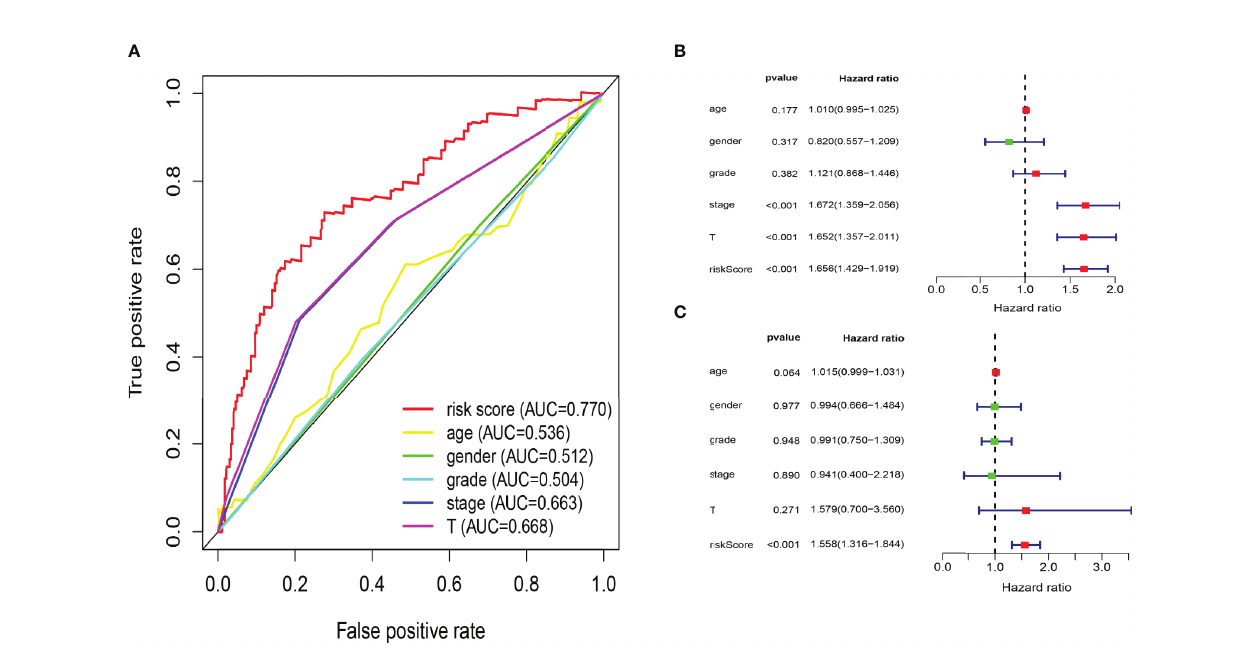
FIGURE 5 | Relationship between the model and clinical characteristics in entire dataset. (A) The AUC values of clinical features and 5-immune-related lncRNAs were analysed, and the fi gure shown that the AUCs all of clinical characteristics were lower than those of the 5-immune-related lncRNA signatures (B) Univariate analysis suggested that the risk scores from the signature, T, and stage were associated with OS (stage: TNM stage, T: tumor stage) (P < 0.001). (C) Multivariate Cox analysis showed that our model could independently predict OS of the HCC patients (P <